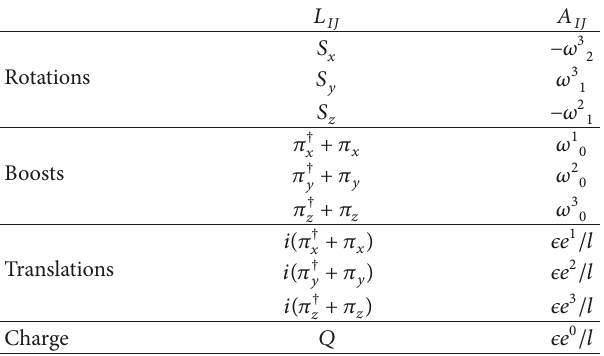
Table 1: Physical correspondence between operators in the con- densed matter system and in the gravitational